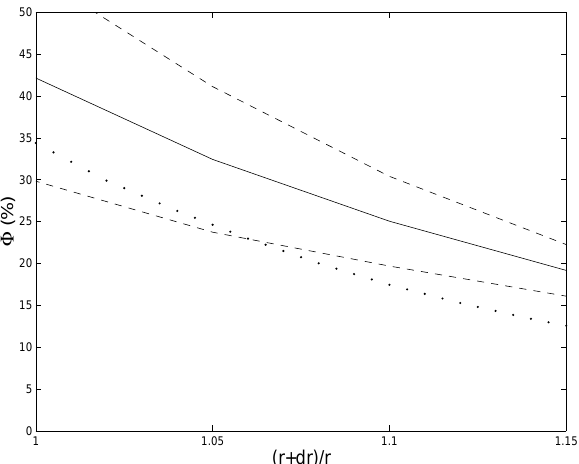
Fig. 6. The variation of 8 SOHO with (r + dr)/r , calculated from SOHO EIT data taken during the eclipse of 11 August 1999 (dot- ted line) in comparison with the mean value µ for 50 days’ data at the same phase of the solar cycle (interpolated from the two mean curves presented in Fig. 3). At all (r + dr)/r , the corrected value 8 S , estimated for the ionospheric eclipse data of 11 August 1999, is lower than the mean value µ for that phase of the cycle. The dashed lines are at plus and minus one standard deviation σ from the mean µ